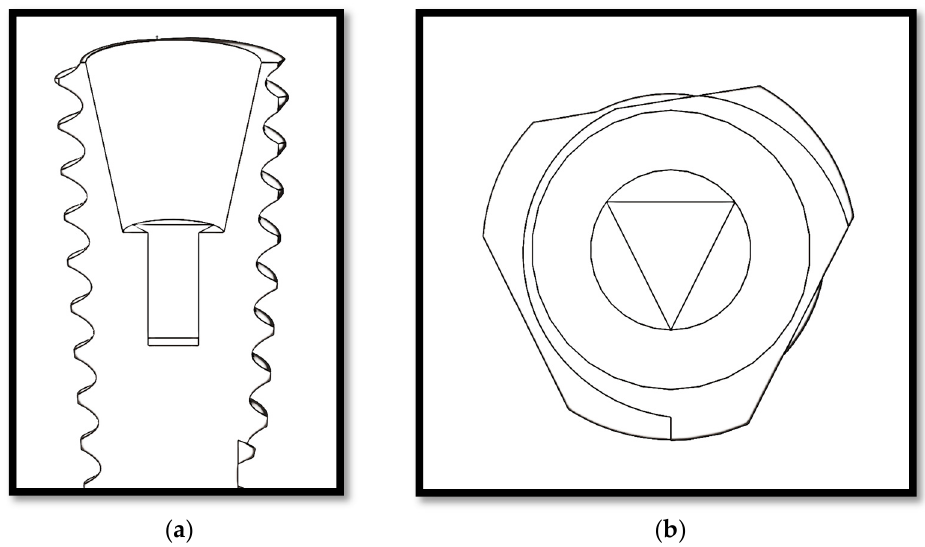
Figure 1. ( a ) Sagittal view of the CT connection; ( b ) occlusal view of the CT connection.